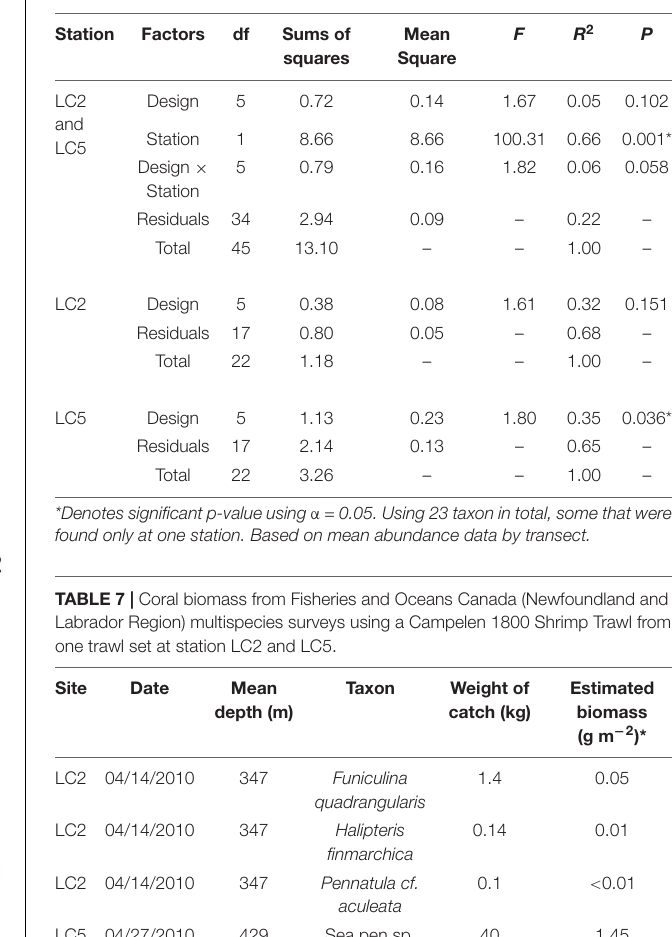
TABLE 6 | Permutational multivariate analysis of variance (PERMANOVA) of distance matrix using Bray–Curtis dissimilarity and 999 permutations examining the effect of sampling designs Campod, ROPOS_ACE, ROPOS_BDF, ROPOS_CEG, ROPOS_DFH (3 400 m transects), and station (LC2 and LC5) in the Laurentian Channel MPA.